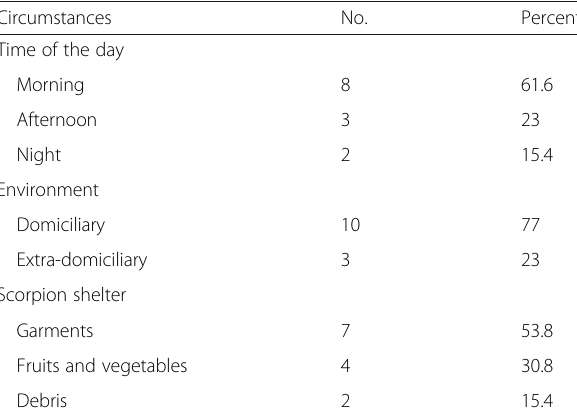
Table 3 Clinical parameters of envenomation in victims